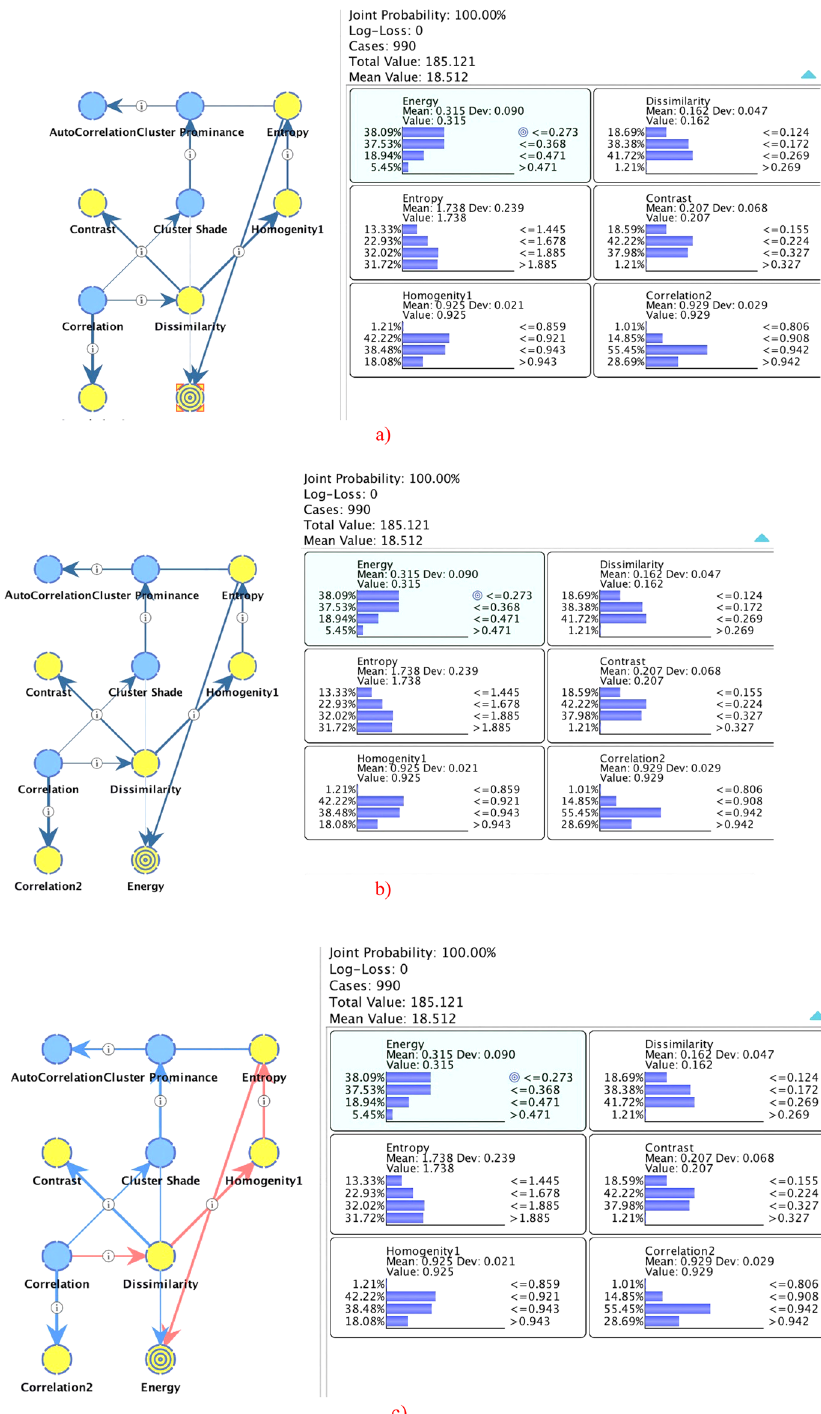
Figure 3. Relationship analysis using different Bayesian inference approaches such as ( a ) mutual information (MI), ( b ) Kullback–Leibler (KL) divergence, ( c ) Pearson’s correlation by applying the unsupervised learning using maximum spanning tree and selecting energy as our target